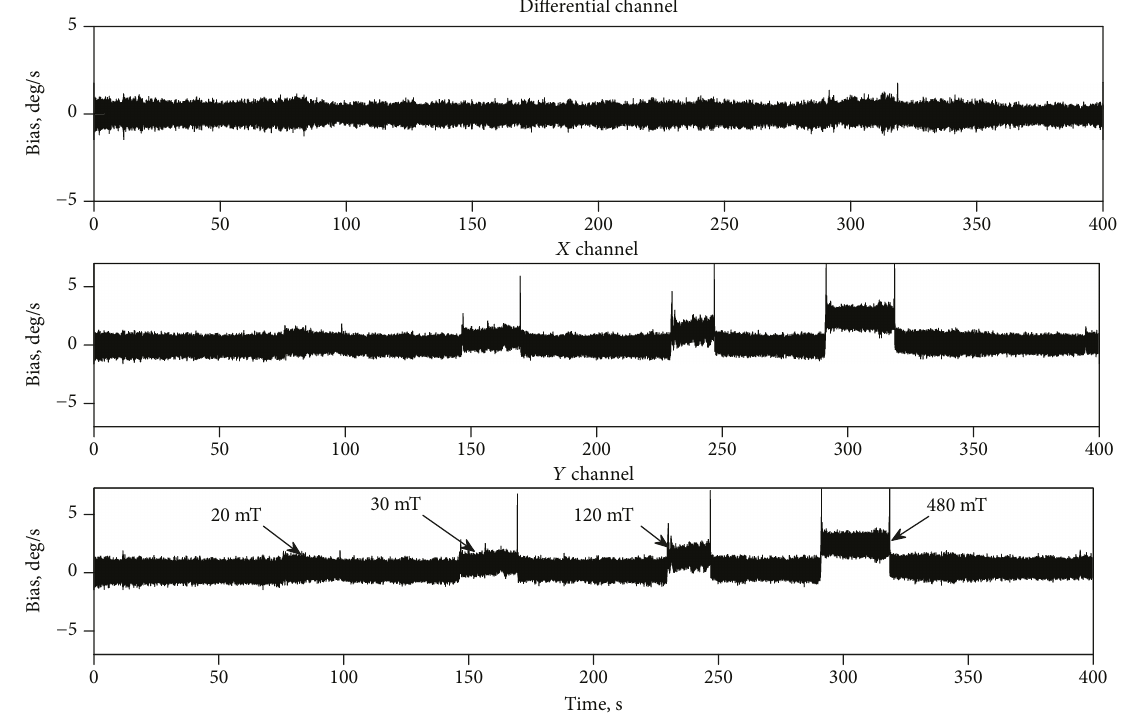
Figure 13: Di ff erential CVG signal responses to magnetic fi eld